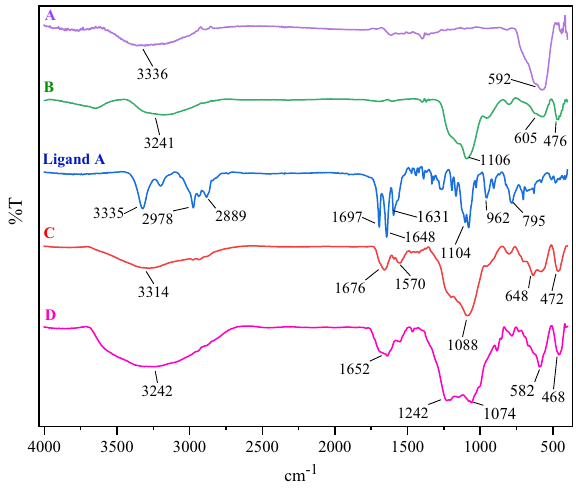
Figure 4. FT-IR spectra of FSiPSS and the corresponding